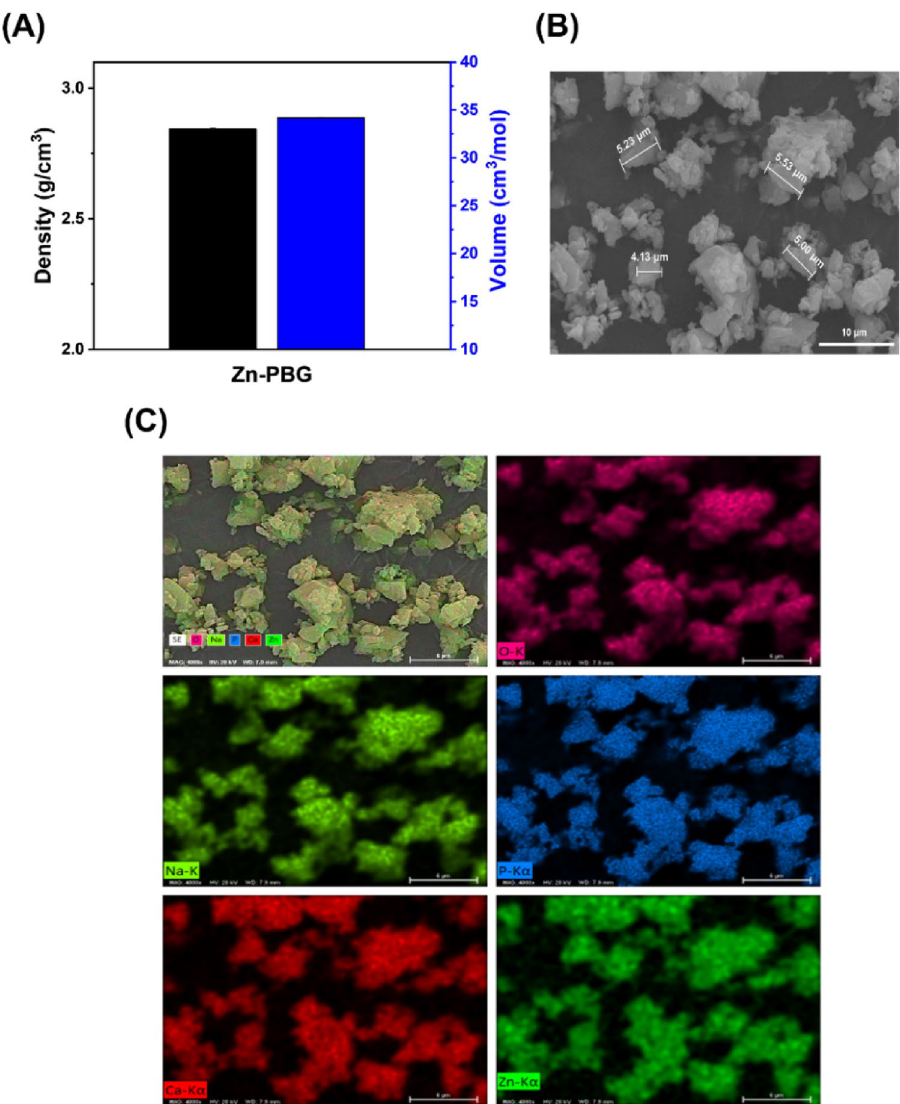
Figure 1. ( A ) Density and volume of Zn-PBG powder, ( B ) Energy-dispersive X-ray microscopy (EDS) images of Zn-PBG powder, and ( C ), EDS mapping images of various